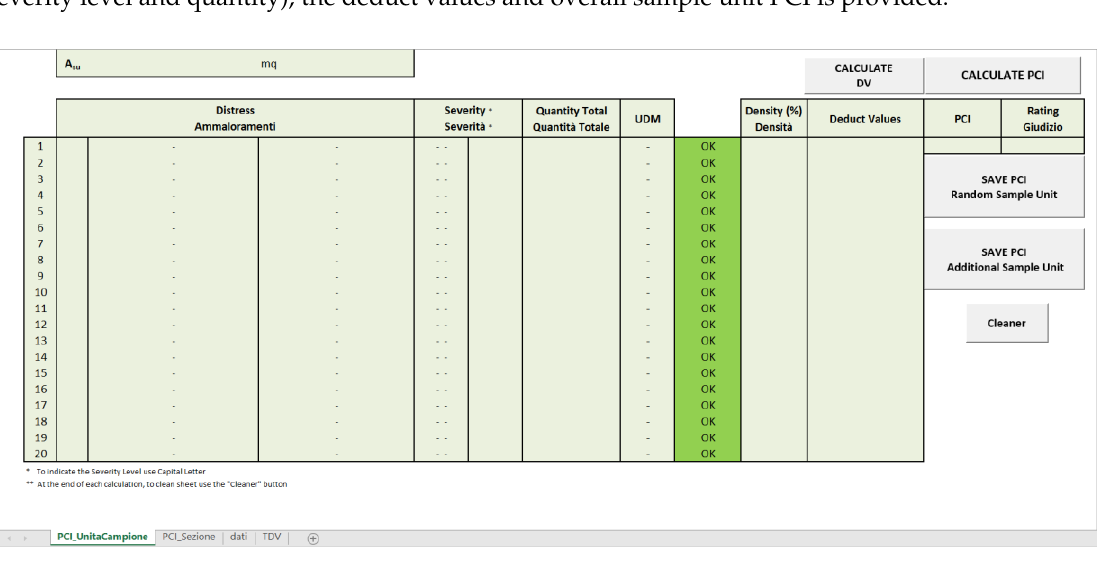
Figure 4. Automated PCI calculation procedure Visual Basic for Application (VBA) program interface.